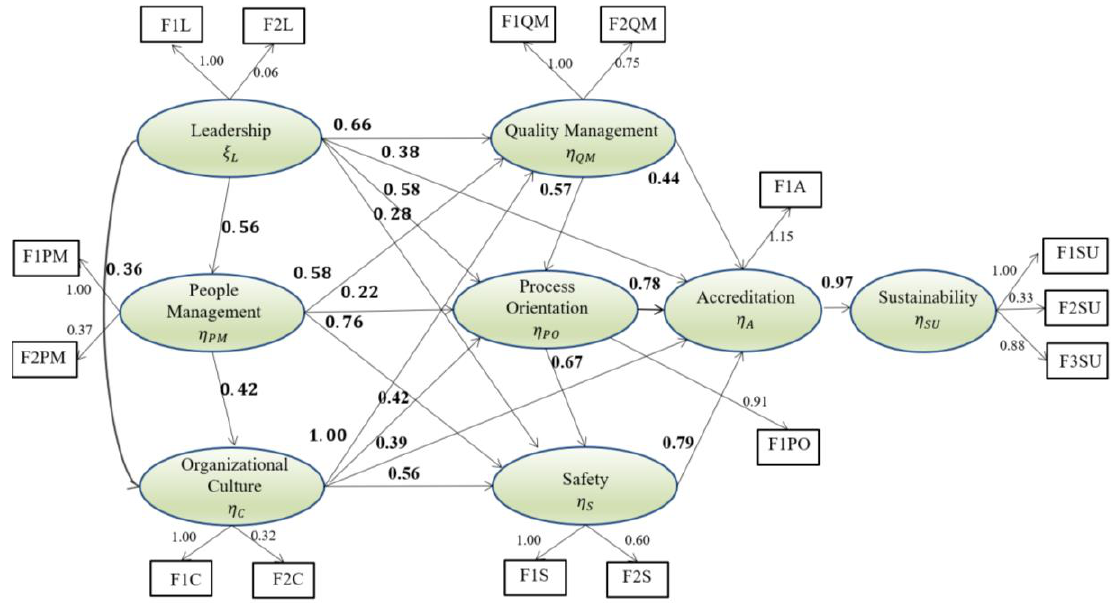
Figure 2. Standardized estimations of the calibrated model.